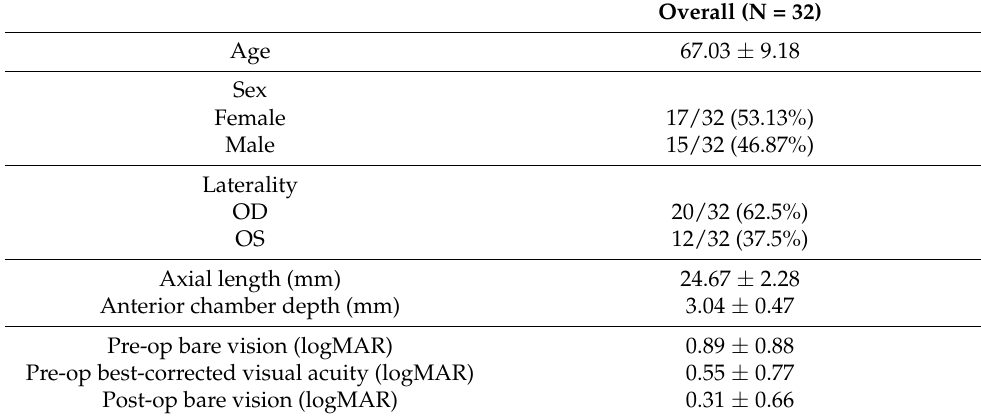
Table 1. Demographic